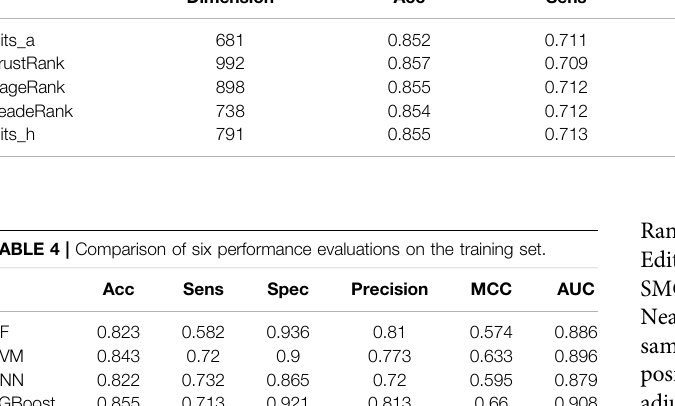
TABLE 3 | The results of using different sorting methods in MRMD on the training set. Dimension